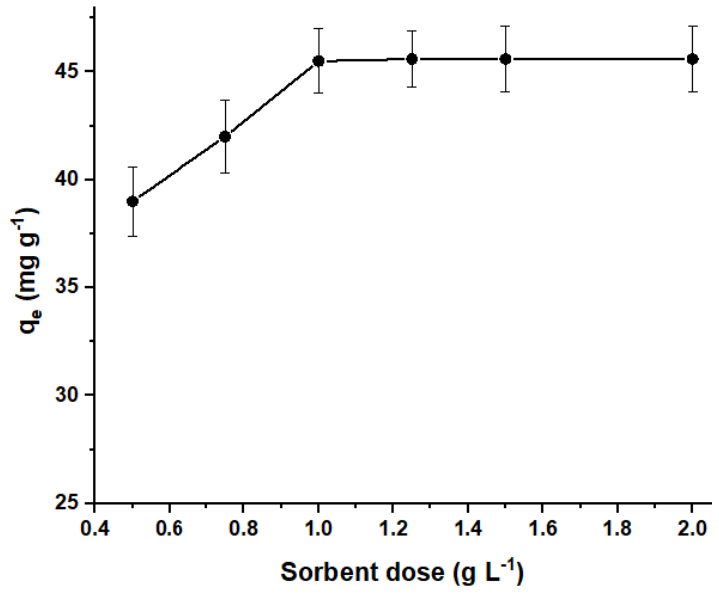
Figure 6. Effect of sorbent dose on the removal of COD by the activated